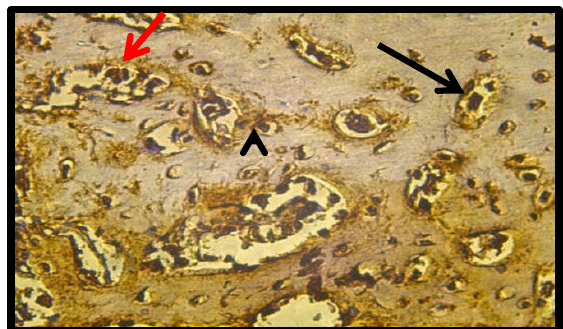
Figure (2) : Osteocyte (arrow heads) and osteoblast (arrows), bone marrow stromal cells (BMSCs) show positive BSP expression in control group 14 days. Negative expression in trabecular bone (BT) DAB stainX40